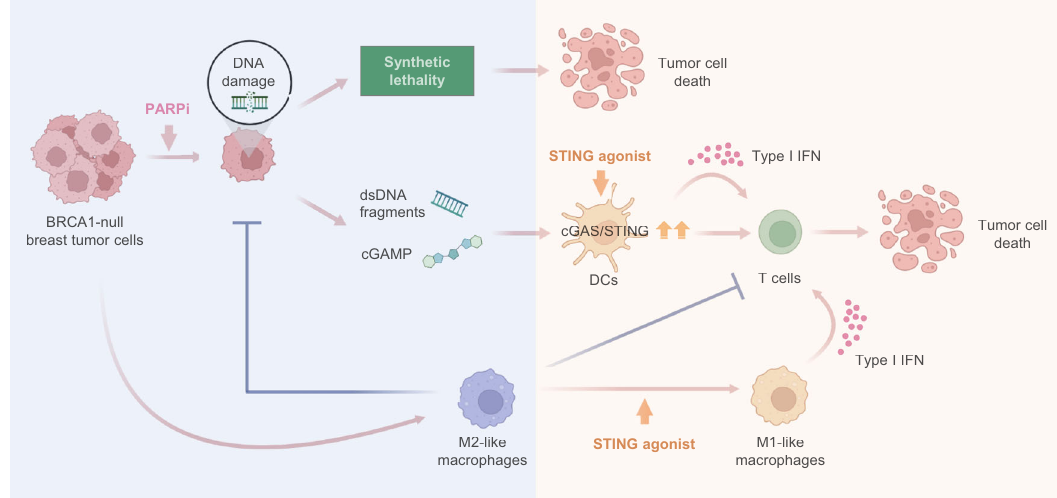
Fig. 7 Harnessing anti-tumor immunity with STING agonists overcomes immune suppression and resistance to PARP inhibition in BRCA1-de fi cient breast cancer. BRCA1-de fi cient breast tumors elicit pro-tumorigenic macrophage polarization. In turn, these tumor-educated macrophages not only exhibit suppressive activity against T cells, but also attenuate PARPi-mediated synthetic lethality and the production of double-stranded DNA (dsDNA) fragments, thus diminishing the activation of the DNA sensing adaptor STING and rendering BRCA1-de fi cient breast tumors resistant to PARPi therapy (blue shading). Exogenous agonists of the STING pathway reprogram the macrophages and trigger innate immune activation of both macrophages and DCs, potentiating PARPi therapy to induce tumor cell DNA damage and an adaptative immune response that re-sensitizes tumors to PARPi therapy (orange